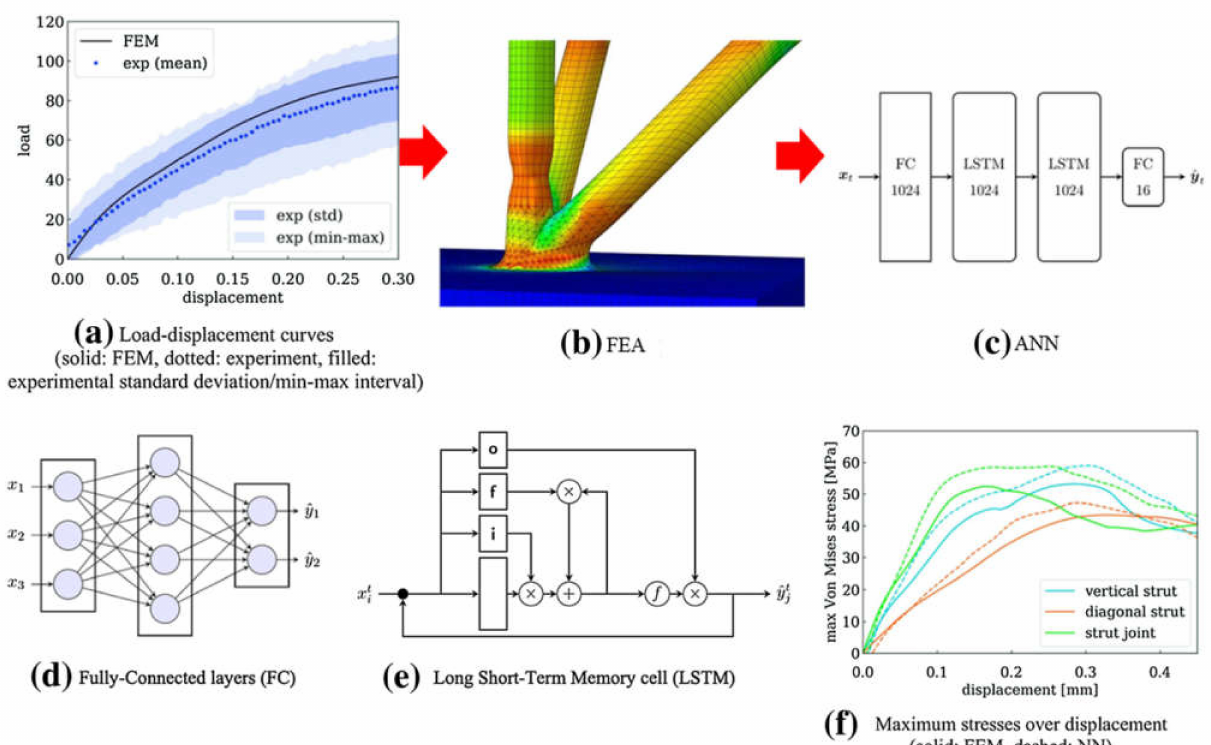
Figure 12. Overview of applying ANN for highly efficient numerical modeling [87]. ( a ) Experimental test to confirm the FE simulation results. ( b ) FE simulation results used as input for ANN. ( c ) ANN architecture containing one fully connected layer followed by two long-short-term memory (LSTM) cells, followed by another fully connected layer. ( d ) Schematics of fully connected layers. ( e ) Schematics of LSTM. ( f ) Comparison with FE simulation showing ANN capability in predicting stresses; with permission from